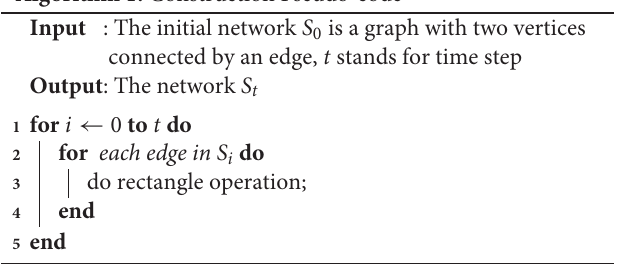
Algorithm 1: Construction